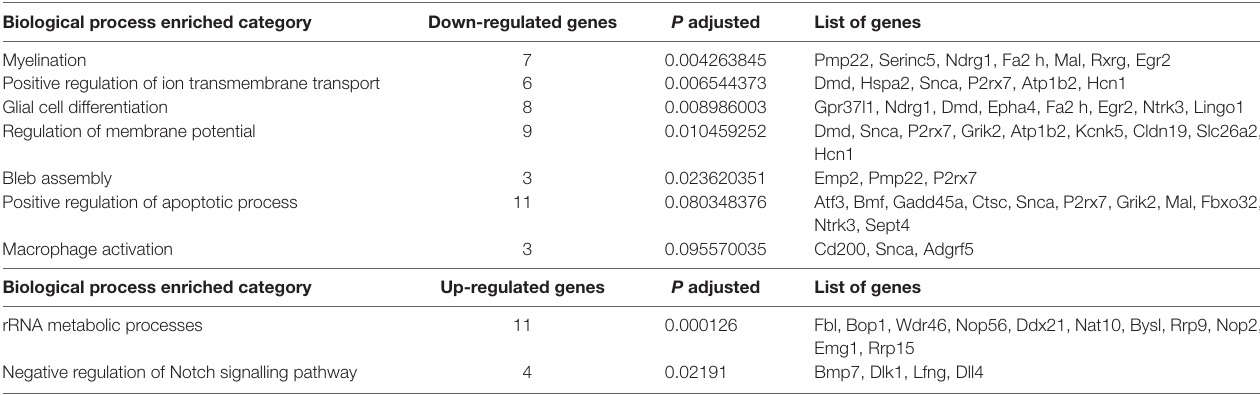
TABLE 2 | Biological process (BP) enriched categories obtained by Gene Ontology